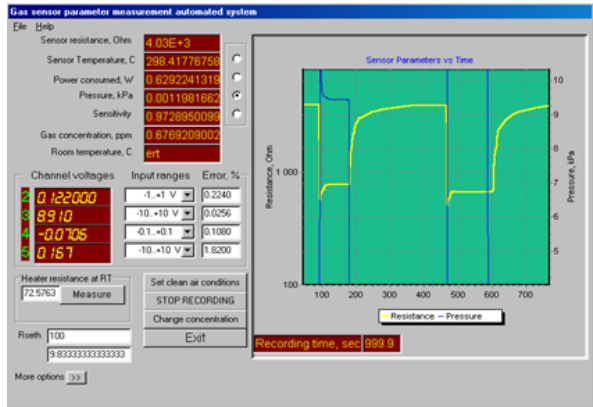
Figure 2. The window of the control